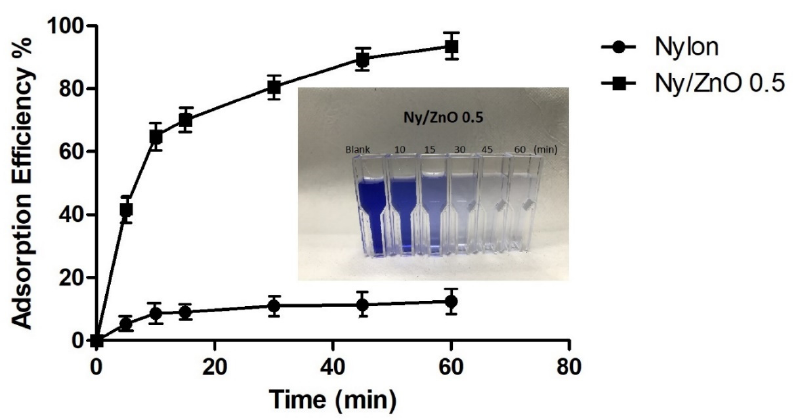
Figure 8. The adsorption efficiency of nylon and Ny/ZnO 0.5 (MB concentration = 200 mg/L, nanocomposite content = 20 mg/20 mL, T = 25 °C and t = 60 min).